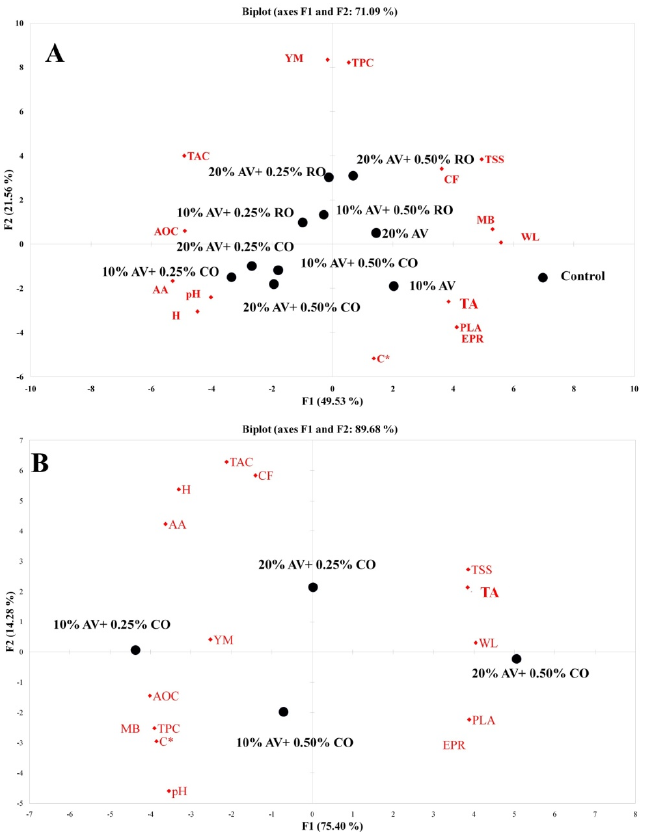
Figure 10. PCA bi-plot of the physiological, physical, chemical, enzymatic, phytochemical, and antioxidant attributes of ‘Bhagwa’ pomegranate arils that were coated with Aloe vera (AV) gel coatings that were enriched with rosehip oil (RO) (0.25% or 0.50%) and cinnamon oil (CO) (0.25% or 0.50%) and stored at 5 ± 1 °C (95 ± 2% RH) for 15 days. Where two principal components of bi-plots were ( A ) 48.53% and 21.56% for 9 day pomegranate arils and ( B ) 75.40% and 14.28% for 15 day pomegranate arils.